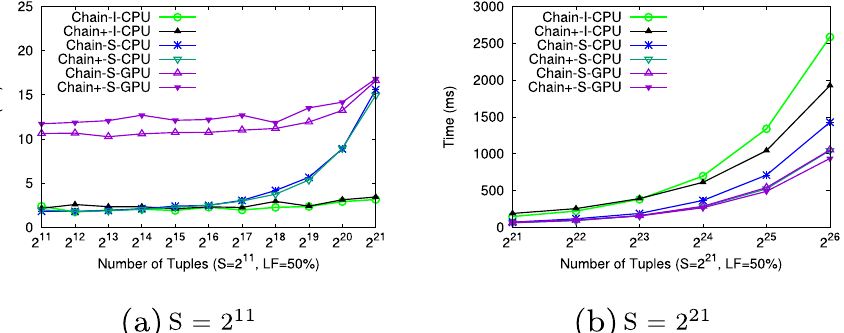
Fig. 10 Comparison between two kinds of chained hashing as the number of tuples changes with different hash table